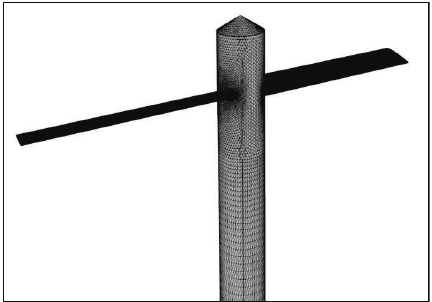
Figure 12: Caradonna and Tung rotor and surface